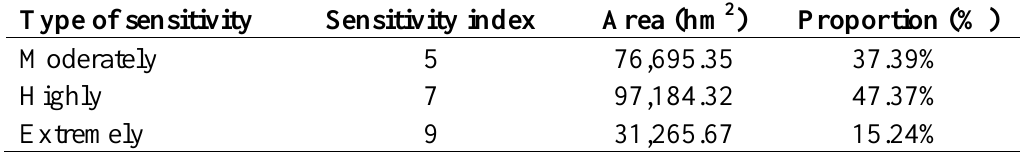
Table 3. Atmosphere sensitivity evaluation results for Yicheng City.